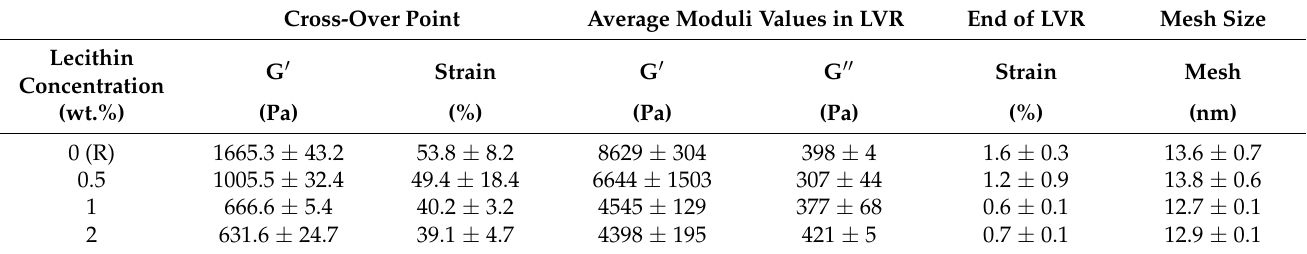
Table 7. Values for chemically crosslinked PVA-chitosan hydrogels obtained from strain and fre- quency sweep tests before